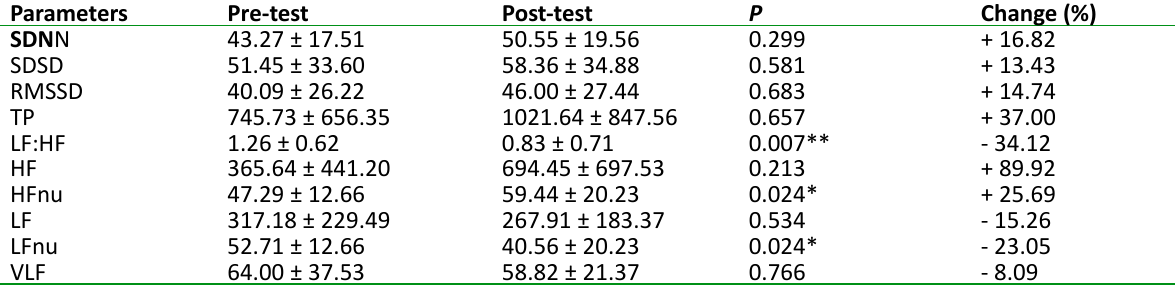
Table 2. HRV results of the experimental group.